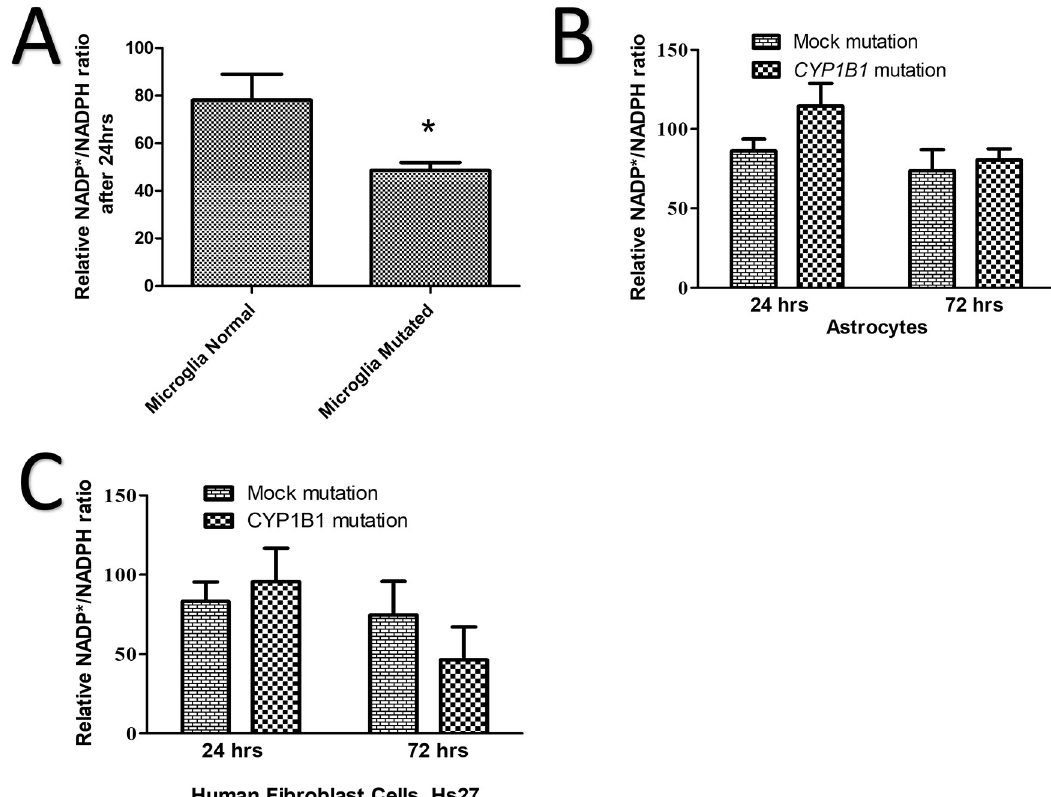
normalised percentage of the reducing equivalent ratio of NADP � /NADPH comparing the control (mock) astrocytes to mutated ones after 24 and 72 hrs, showing no significant difference. (C) The normalised percentage of the reducing equivalent ratio of NADP � /NADPH comparing the normal Hs27 to the mutated ones after 24 and 72 hrs, showing no significant difference. An asterisk ( � ) is displayed when the p-value was less than or equal to 0.05; N =